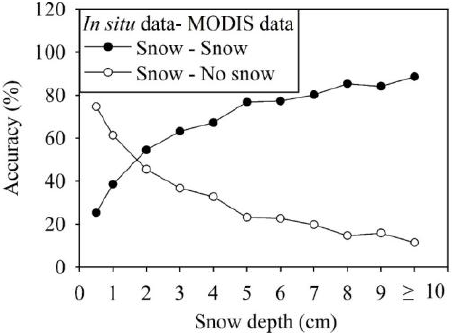
Figure 5. The accuracy of MODIS snow cover products under snow cover event of ground station. Note that the accuracy of snow–snow indicates the snow detection rate.